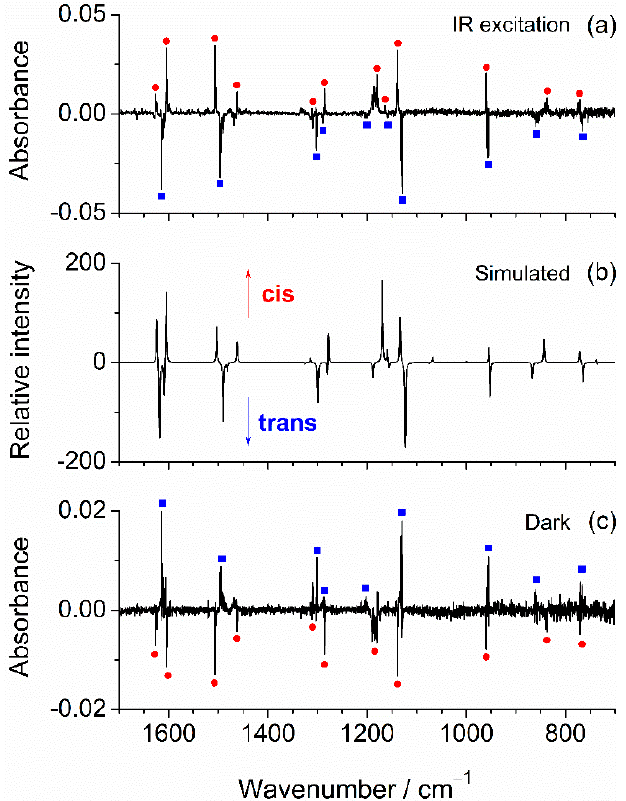
Figure 3. ( a ) Experimental difference IR spectrum of m FP monomers in N 2 matrix, obtained by subtracting the spectrum recorded in the presence of a long-pass cut-off filter that is not transparent to the radiation above ~2200 cm − 1 , from that recorded after removing the filter and letting the sample exposed to the unfiltered radiation emitted from the spectrometer for ~40 min (positive bands are those growing up during exposition of the sample to the unfiltered IR light); ( b ) Simulated B3LYP/aug-cc-pVTZ difference spectrum: cis “minus” trans ; ( c ) Experimental difference IR spectrum obtained by subtracting the spectrum recorded after the enrichment of the sample with the cis form from that recorded after keeping the sample in the dark for 90 min (positive bands correspond to those increasing during the time of permanence in the dark). Both spectra were collected in the presence of the long-pass filter.